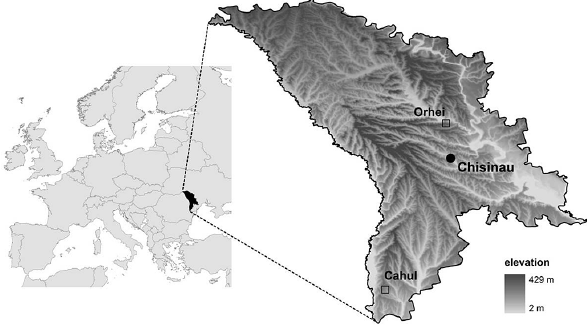
Figure 1. Topographic map of the Republic of Moldova showing the location of the study sites in the districts of Cahul and